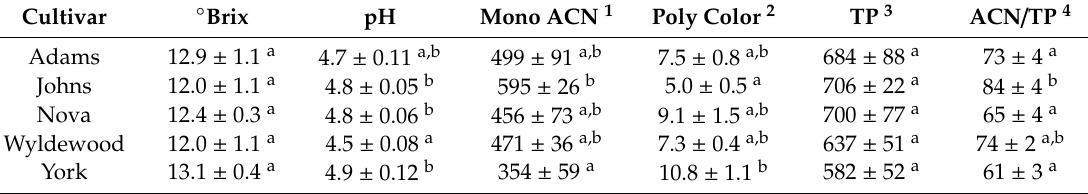
Table 1. Fruits’ phytochemical attributes comparison among di ff erent American elderberry cultivars. Results expressed as mean ± SD ( n = 3). Cultivars with di ff erent superscripts were significantly di ff erent ( p < 0.05). Cultivar ◦